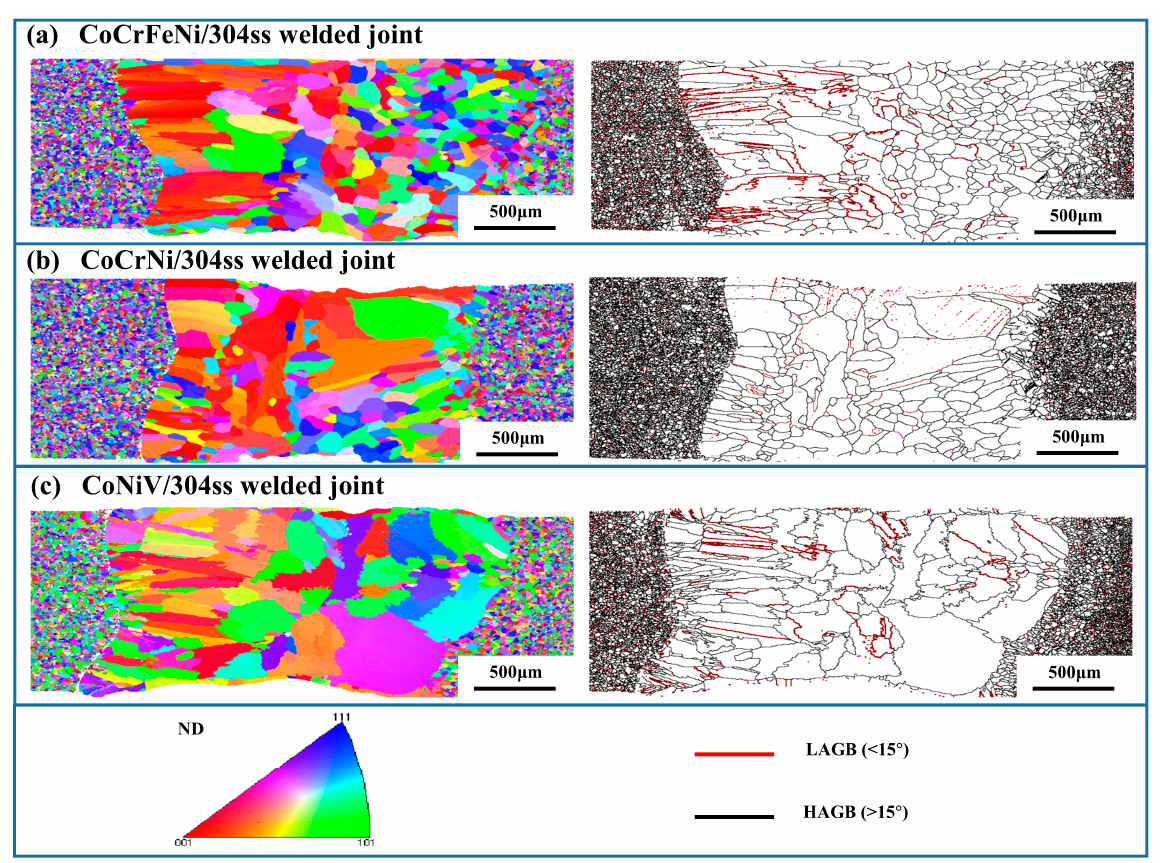
Figure 5. IPF images and grain boundary diagrams of different welded joints obtained by EBSD. ( a ) CoCrFeNi/304ss welded joint; ( b ) CoCrNi/304ss welded joint; ( c ) CoNiV/304ss welded joint. Note that, LAGB and HAGB indicate low-angle grain boundary and high-angle grain boundary,